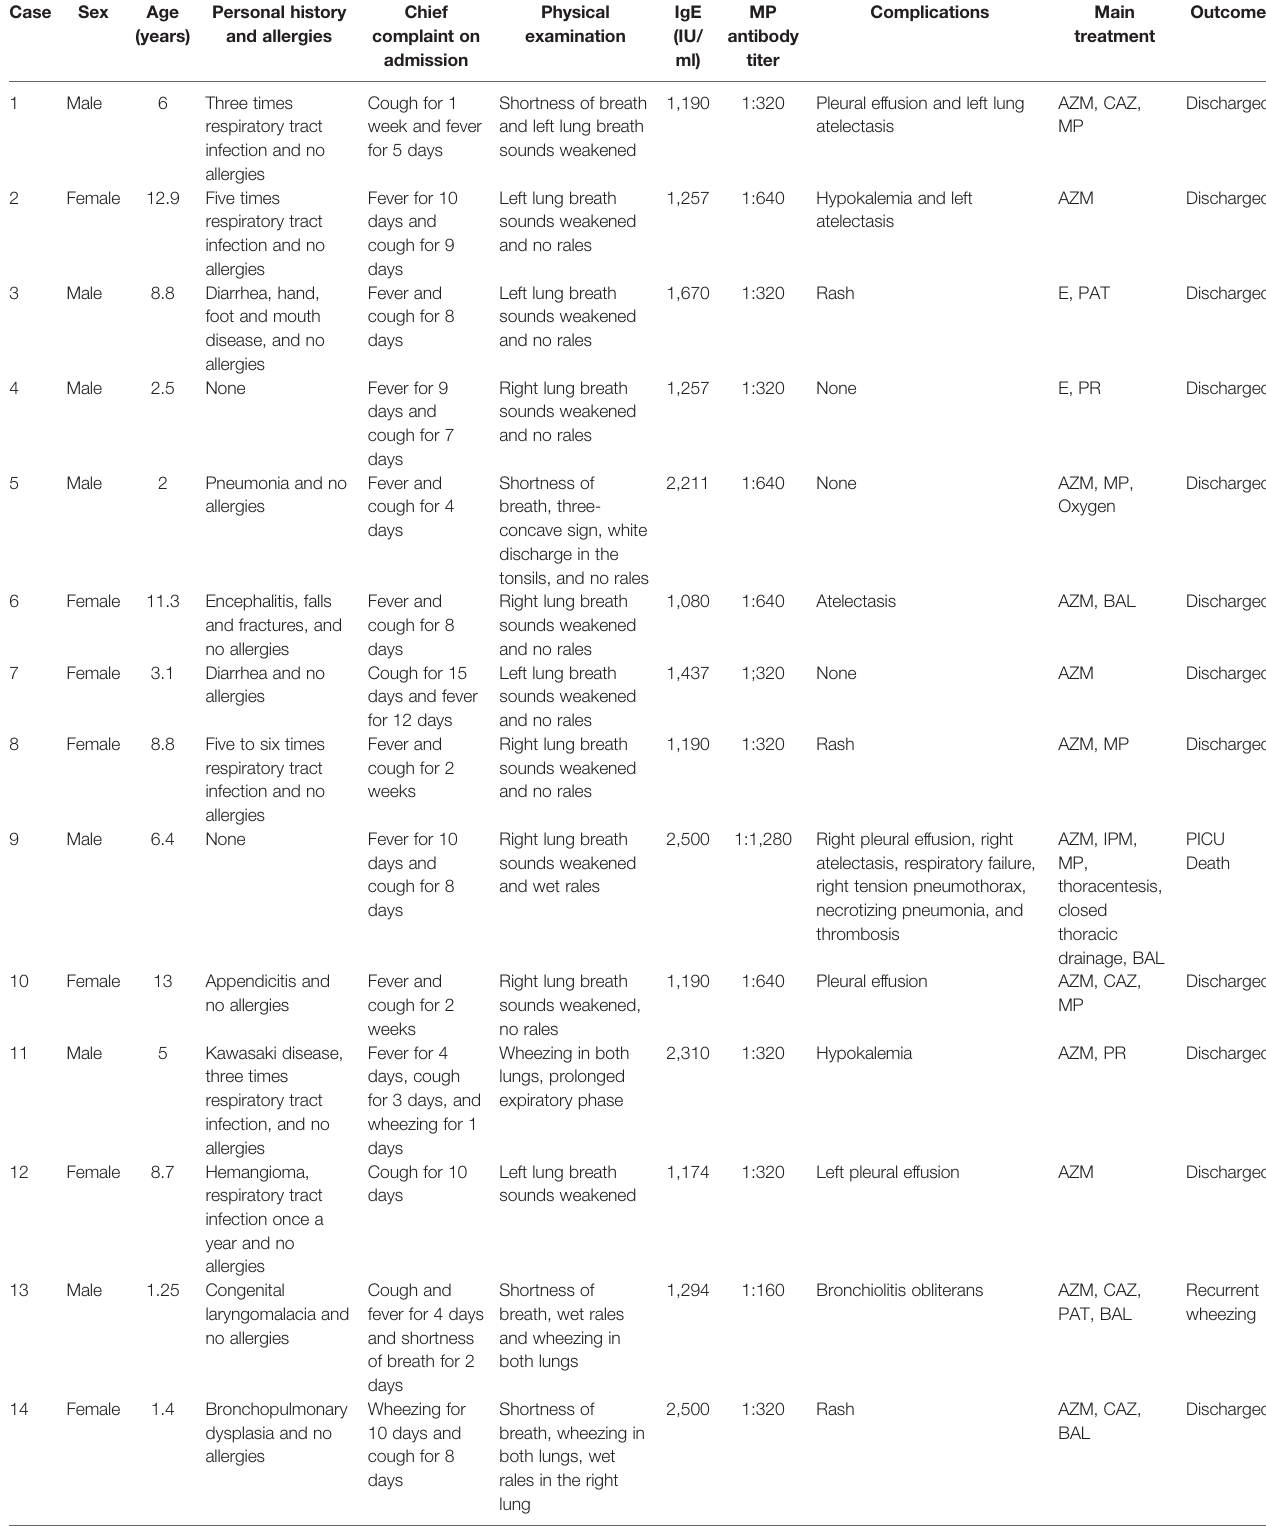
TABLE 5 | Information of 14 patients with particularly high